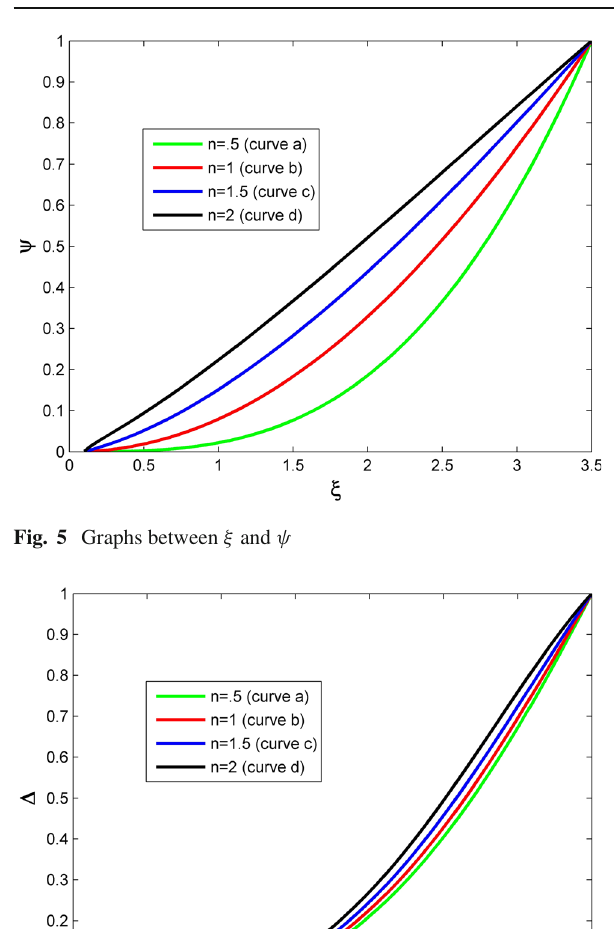
field equations and TOV equation is established. The C- energy is applied to develop a expression for mass